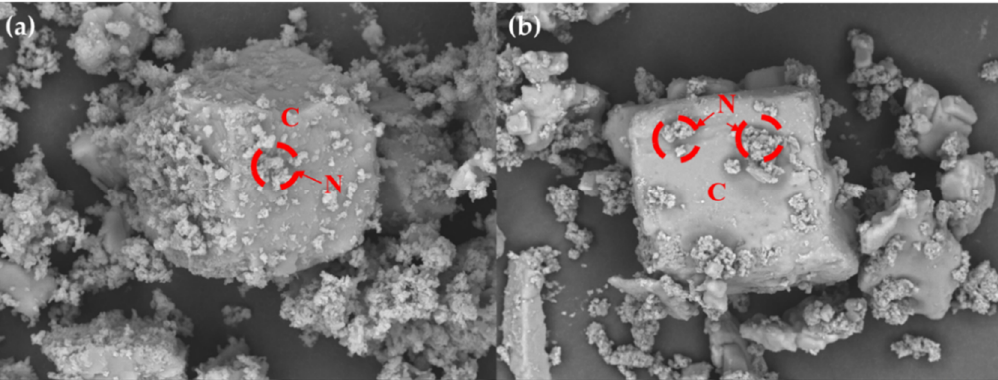
Figure 6. SEM image of carbonate in 5 wt % DEA and MDEA solution: ( a ) DEA solution and ( b ) MDEA solution. (N: NaCl, C: calcite).